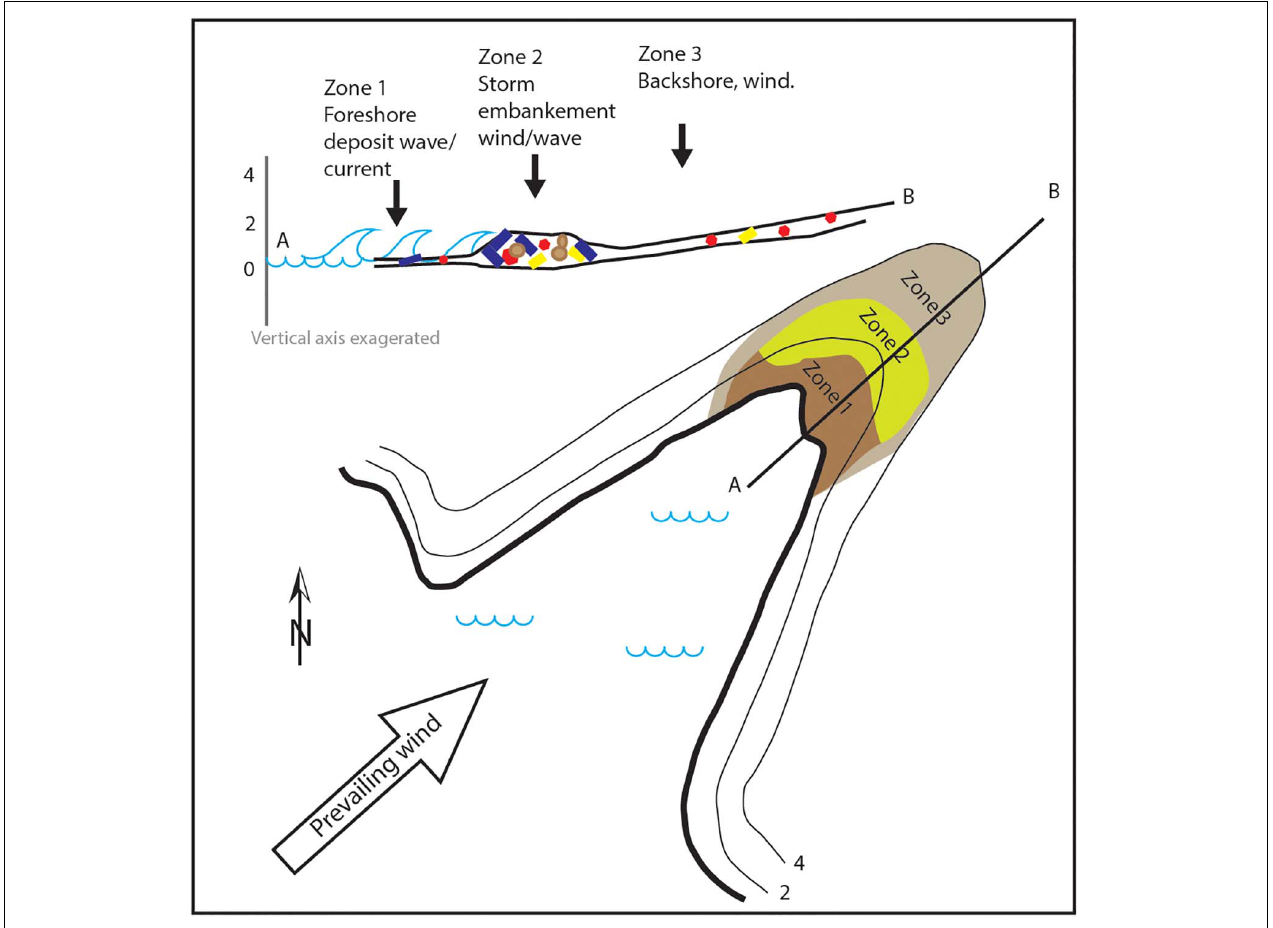
FIGURE 3 | Conceptual sketch of wreck bays based on observation in the two localities. Zone 1 foreshore deposition. Zone 2 backshore/storm embankment, Zone 3 area of dominantly wind deposited